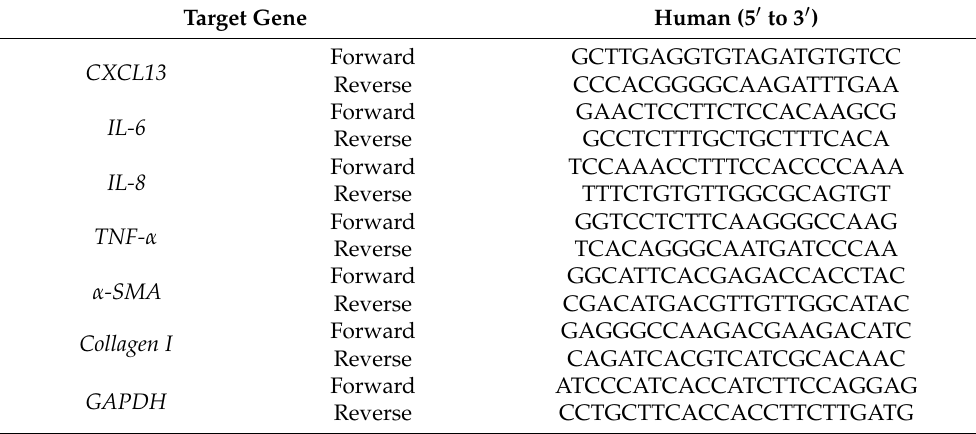
Table 4. Primer sequence used for qPCR.